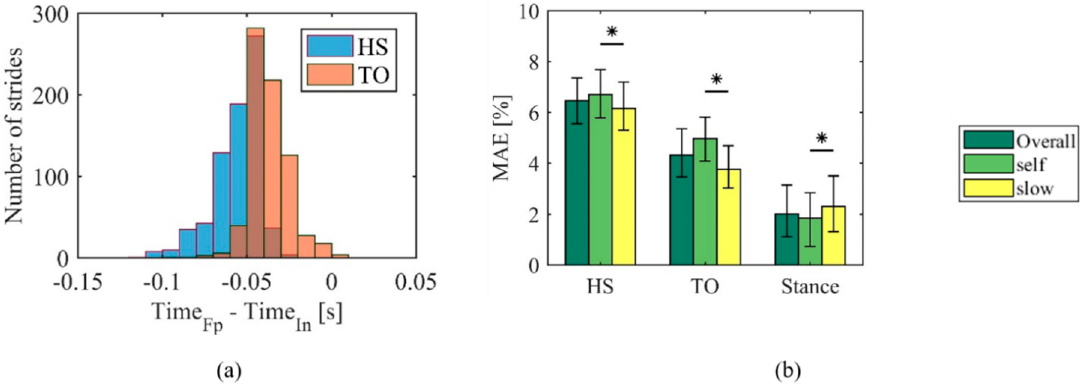
Figure 4. ( a ) Histogram distribution of the difference between the instants of force platform and insole gait ‐ event detection for all the analyzed strides. Blue bars refer to heel ‐ strike (HS) events; orange ones to toe ‐ off (TO). Bar width was set equal to the sampling time. ( b ) Median Absolute Error (MAE) for the HS and TO events and for stance duration, expressed as percentage of the stance duration. The MAE was computed over (i) all the recorded strides (Overall), the strides at self ‐ selected speed (self), and the strides at slow speed (slow).